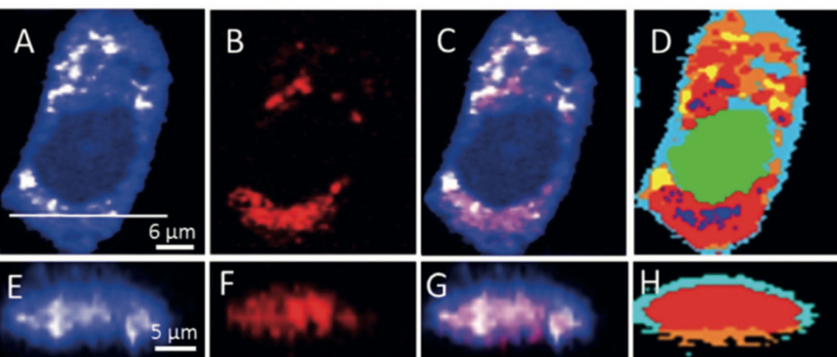
Figure 5. Raman imaging of SK-BR-3 cells treated with 5 µ M neratinib for 8 h. Raman images reconstructed from the CH deformation ( A ) and CN stretching ( B ) intensities. ( C ) Overlay of Panels A and B. ( E – G ) Cross-section of Raman images of the same cell measured along the x–z axis. Scanning positions are indicated by the white line in Panel A. ( D , H ) HCA results based on the Raman data shown in Panels A and E. Reprinted with permission from reference